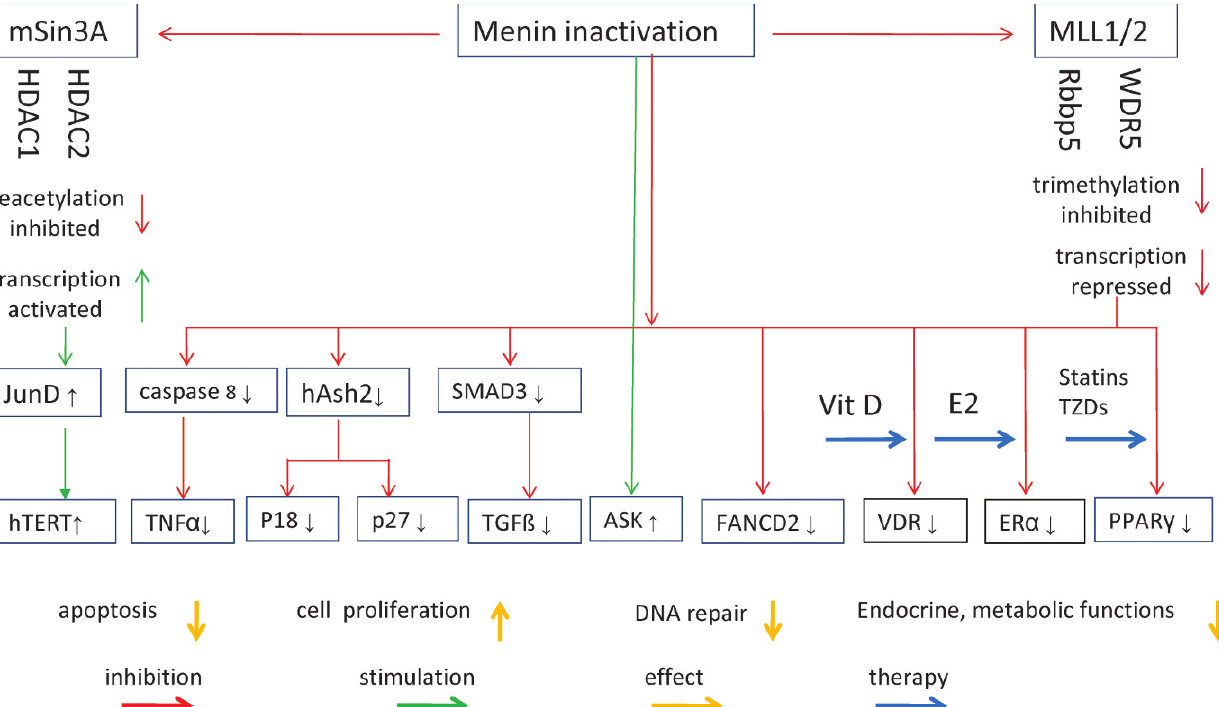
Figure 1 - In MEN1 tumors, inactivating mutations in the MEN1 gene result in alterations of histone protein modifications: both deacetylation (left) and trimethylation (right) are repressed. In this way, the normal function of menin acting as co-repressor and co- activator of gene transcription is disabled. Consequently, the normal function of menin (preservation of differentiation of the cell by modification of histone proteins and transcription of genes responsible for inhibition of cell division) is defective. Red arrows indicate inhibition of apoptosis, cell differentiation, DNA repair, and endocrine metabolic functions, whereas stimulators of cell division are indicated in green. Opportunities for tumor treatment are indicated in blue. E2 = estradiol; TZDs = thiazolidinediones; VDR = Vitamin D